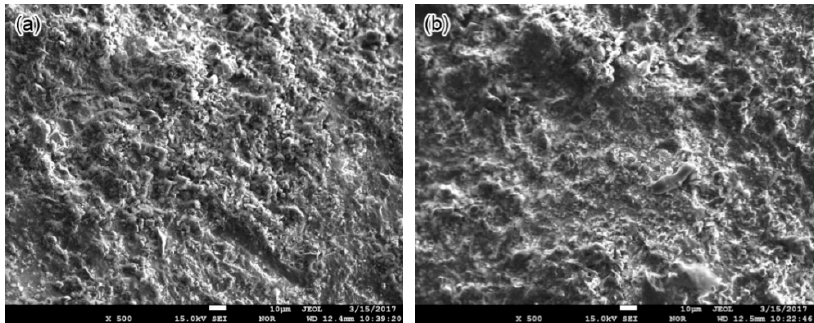
Figure 3. Top view of corrosion scales on the 2 ″ pipe: ( a ) flat area and ( b ) raised area.